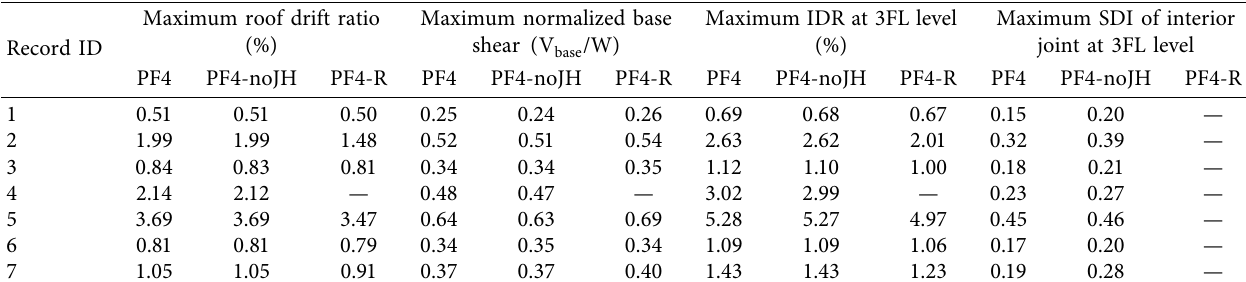
Figure 13: Hysteretic behavior and base shear demand. (a) A four-story frame. (b) An eight-story frame. Table 3: Seismic demands placed upon the four-story frames for the selected ground